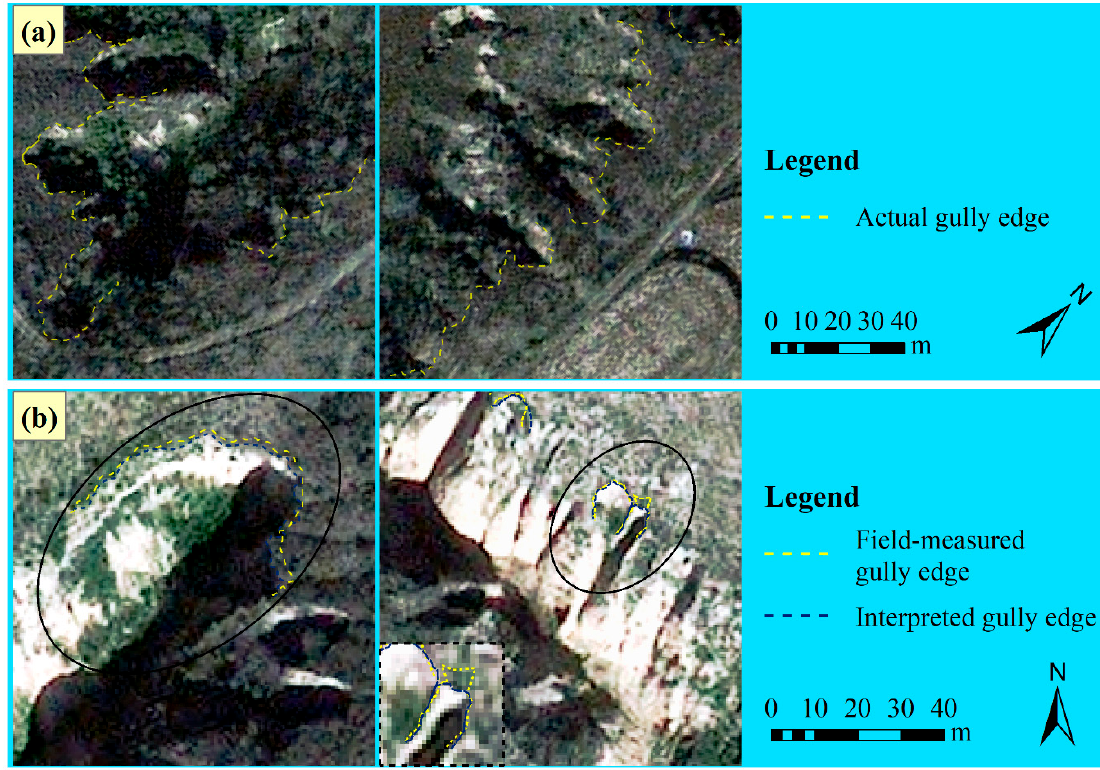
Figure 8. Gullies with dense vegetation cover ( a ) and high and overhanging gully scarps ( b ). Pleiades image was displayed as true color composite with a spectral band combination of B2, B1 and B0 assigned to red, green and blue, respectively.